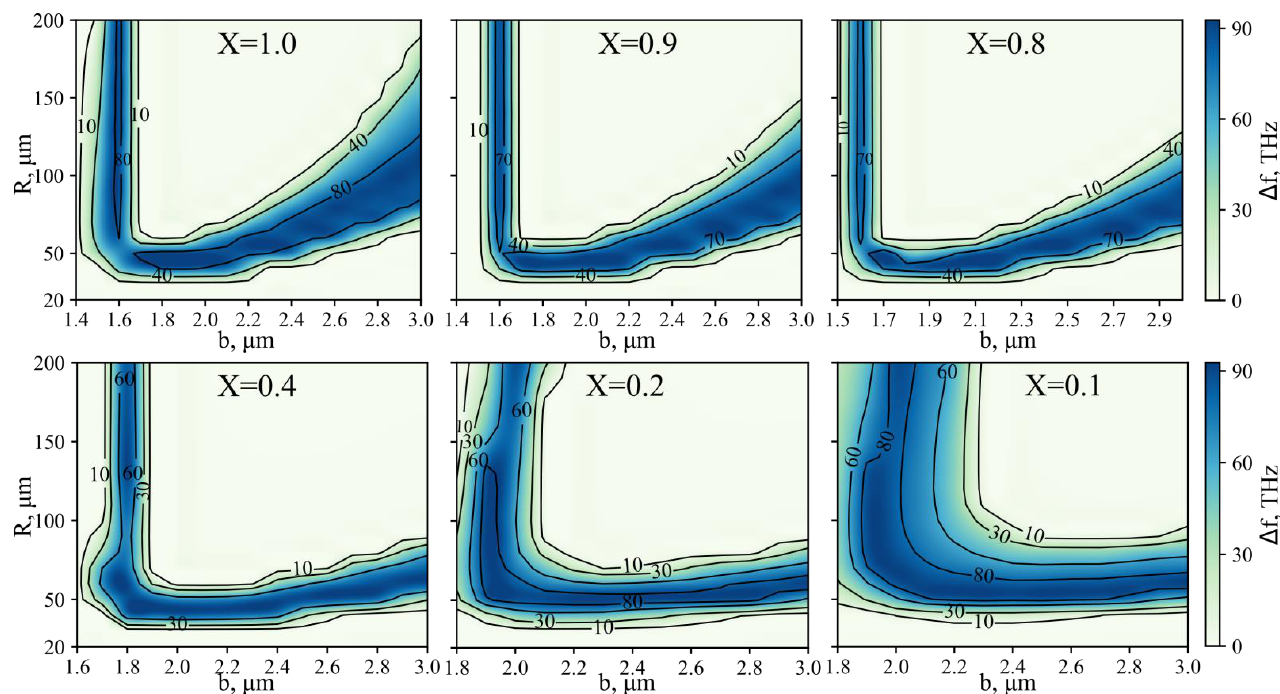
Figure 8. Calculated values of the FWM satellites’ tunability span Δ f (in THz) for pump wavelengths in the SCL-band. Data are shown for several X that provide wide parameter ranges where near-maximum Δ f is achieved. All figures share the same colormap.